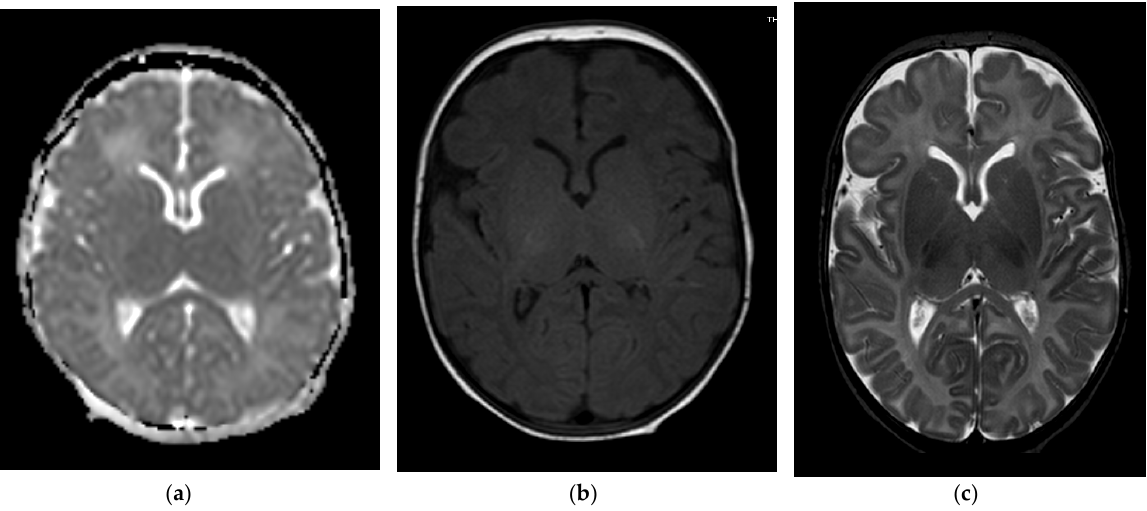
Figure 3. Brain MRI scans of case 2. ( a ) At 5 days of life, DWI showed a normal apparent diffusion coefficient of the brain. ( b , c ) At 40 days of life, T1- and T2-weighted axial spin echo sequence shows normal signal intensity of the brain.